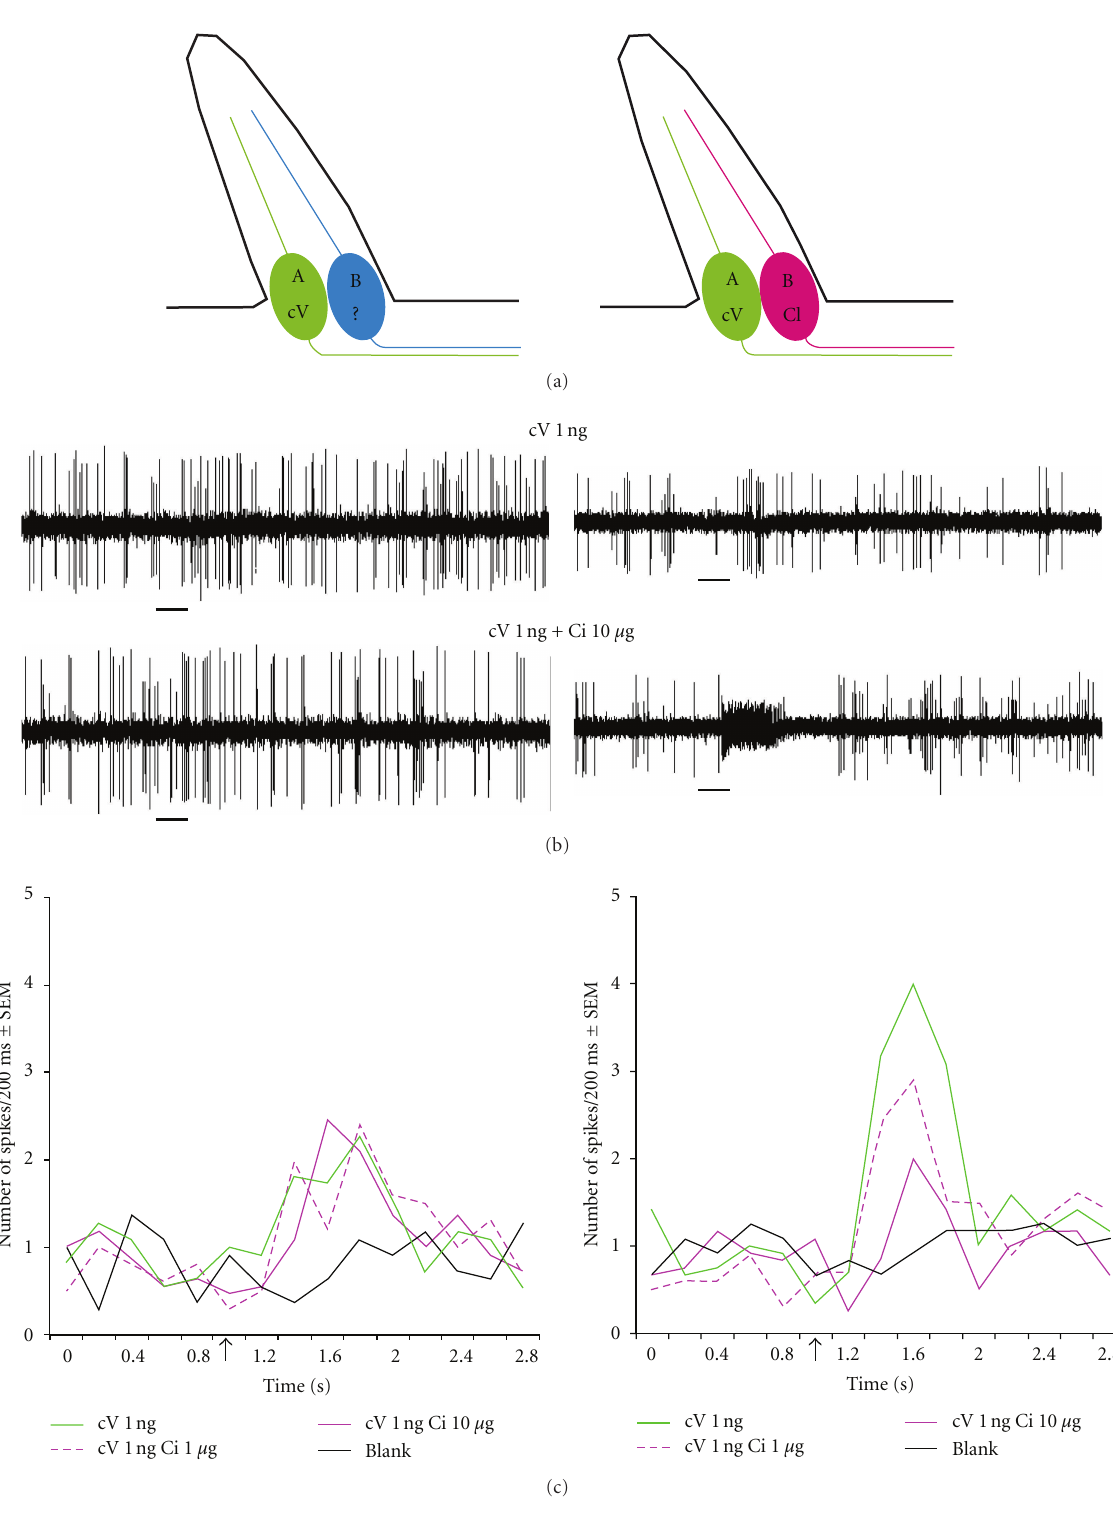
Figure 6: (a) Schematic drawing of the two types of sensilla in Ips typographus containing the A cell (large amplitude spikes) for cis -verbenol (cV), accompanied either by a nonresponsive ( left column ) B cell (small amplitude), or a B cell for 1,8-cineole (Ci) ( right column ). (b) Responses of both sensillum types to 1ng cV ( upper traces ), and a binary mixture of 1ng cV and 10 μ g Ci ( lower traces ). Note the inhibition of the cV response during the response to Ci in the B cell. Black horizontal bars indicate the 0.5s stimulation period. (c) Detailed response curves to cV and binary cV: Ci mixtures showing a Ci dose-dependent inhibition of the cV response only in sensilla that also contain the Ci cell ( N = 10–12). Arrows indicate the onset of the 0.5 s stimulation period (modified from [8], with permission from the